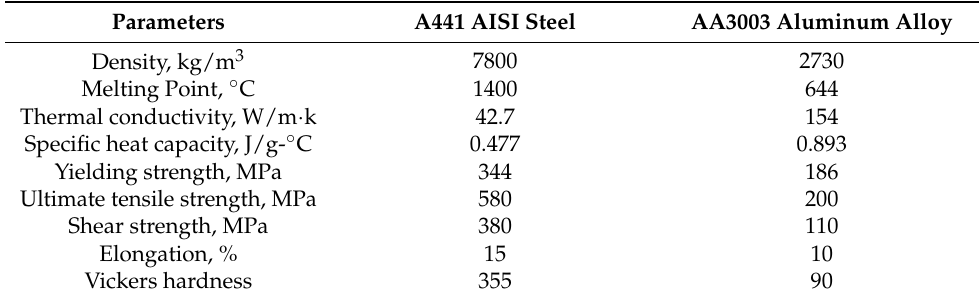
Table 1. Mechanical properties of base metals.